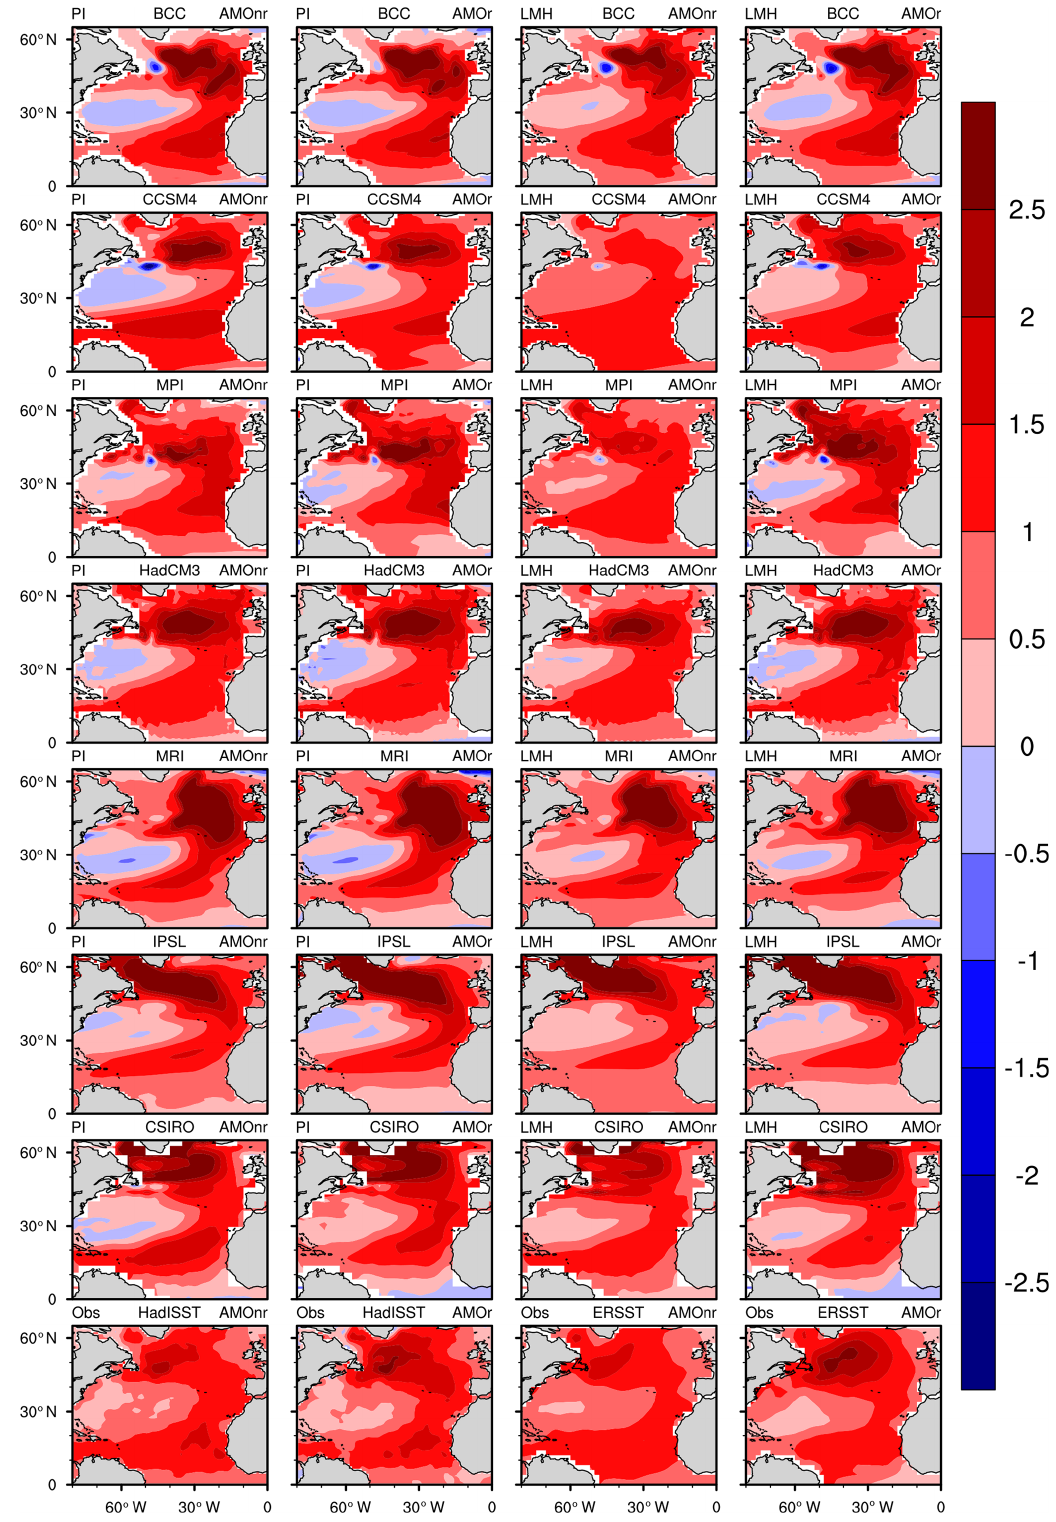
Figure 1. AMO patterns defined by regression of annual-mean SST on the AMO index for each GCM for the PI (first and second columns) and LMH (third and fourth columns) experiments compared with HadISST and ERSST observation (bottom row). The first and third columns use the AMO index calculated without subtracting the global SST anomaly (AMOnr), while the second and fourth columns use the AMO index after subtracting the global SST anomaly